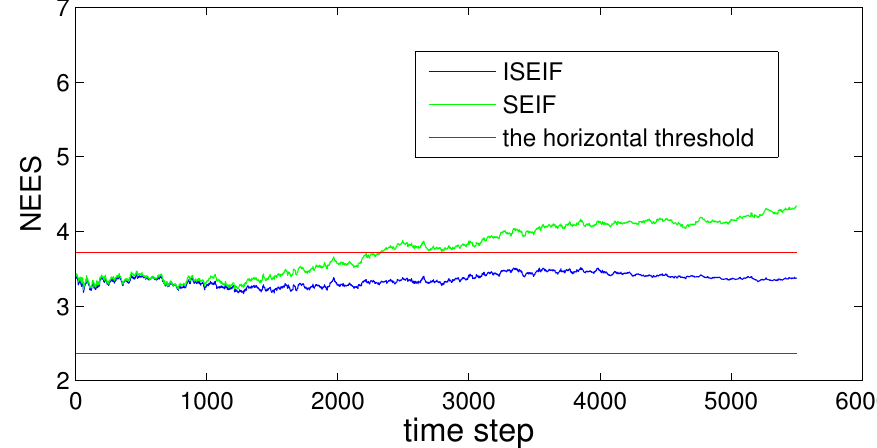
Figure 16. The comparison of NEES for SEIF and ISEIF in the sea trial.